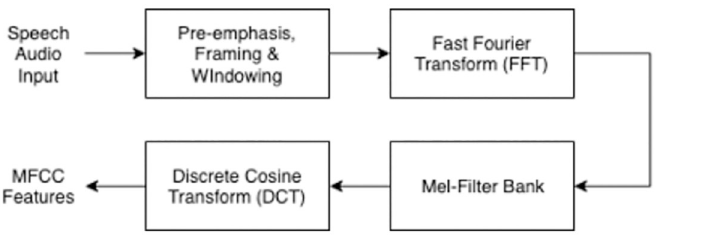
Fig 1. Four main steps of the MFCC feature extraction